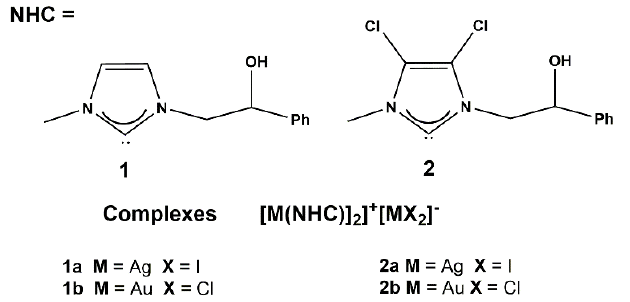
Figure 1. Recently reported NHC silver(I) and gold(I) complexes.